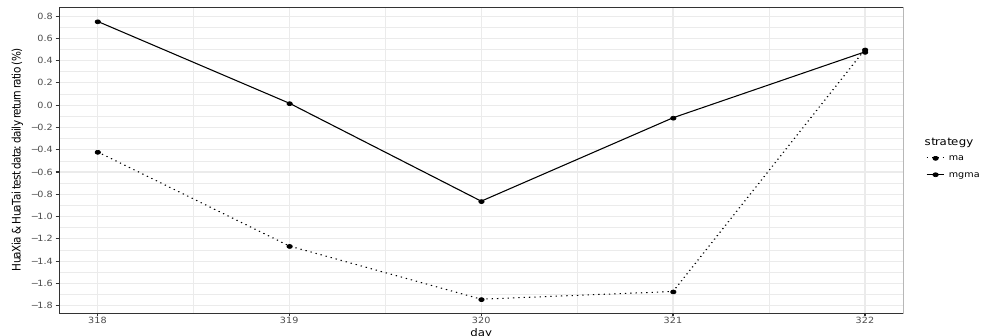
Figure 6. Case 2—MGMA strategy evaluation summary plot for HuaXia ETF and HuaTai ETF